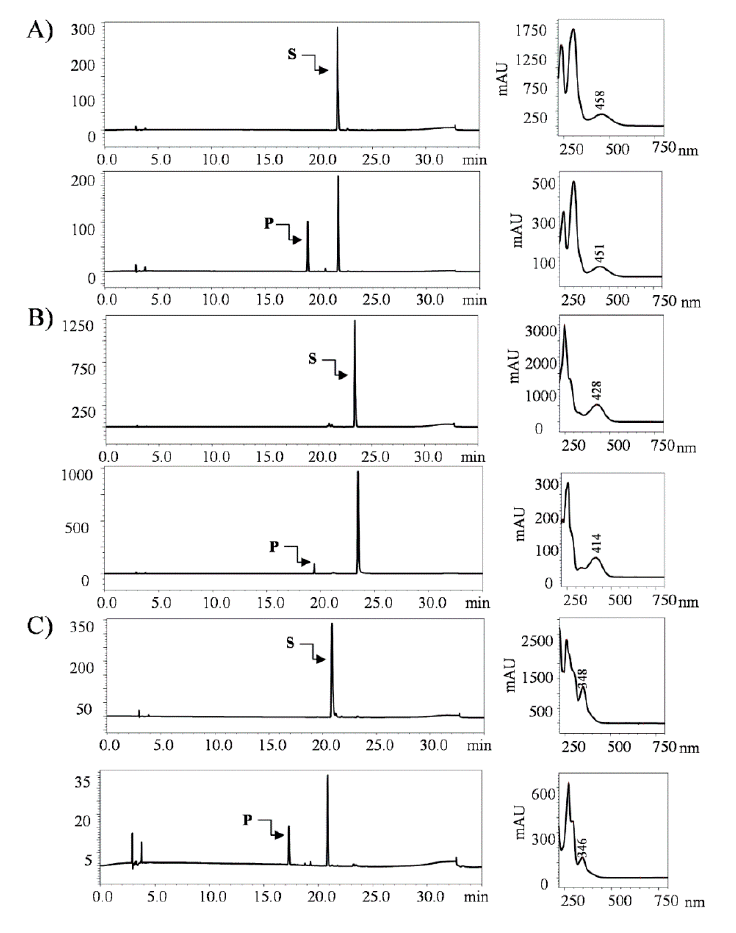
Figure 2. HPLC-PDA chromatogram of biotransformation reaction mixtures compared with respective standards. S refers to the substrate peak and P refers to the product. ( A ) 2-amino-3- hydroxyanthraquinone, ( B ) alizarin, and ( C ) anthraflavic acid.